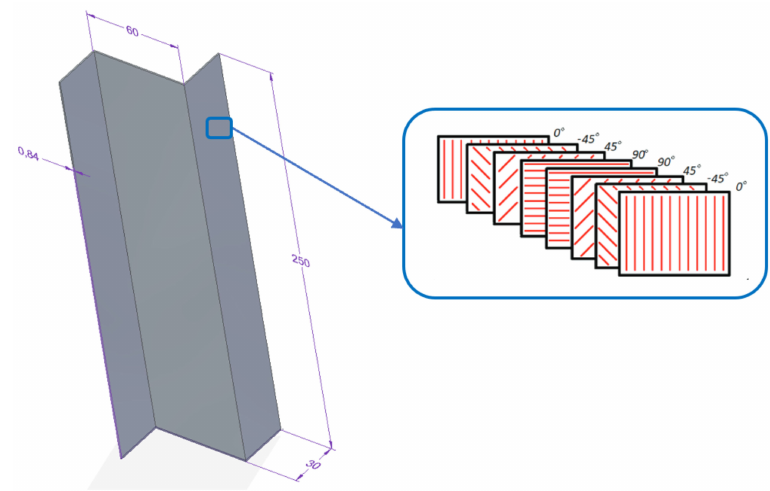
Figure 1. Geometric dimensions of the analysed Z-profile. Table 1. Mechanical properties of carbon–epoxy composite.